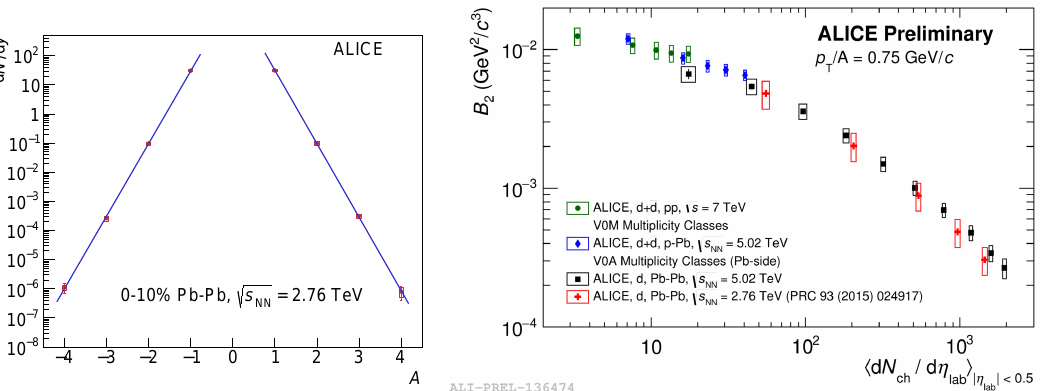
Figure 15. ( Left ) Light nuclei and antinuclei abundances in central (0%–10%) Pb–Pb collisions at √ s NN = 2.76 TeV [39]; and ( Right ) deuteron coalescence parameter as derived from Equation (3) as a function of charged particle multiplicity (for different collision systems).